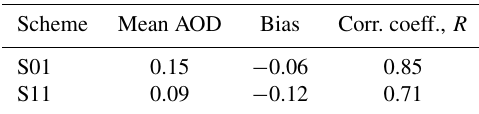
Table 3. Mean AOD predicted by the two model schemes, as well as their bias and temporal correlation with respect to corresponding AERONET